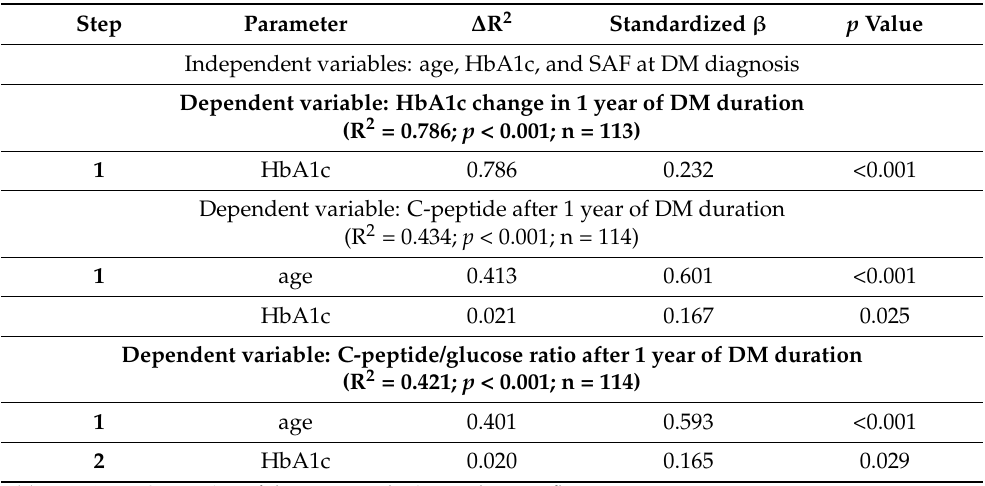
Table 4. Multiple forward linear regression of selected T1D parameters as dependent variables.